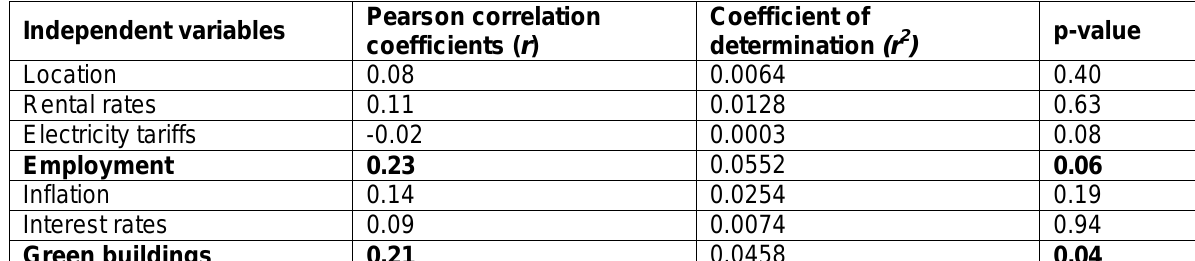
Table 6: Pearson correlation coefficients, coefficient of determination and probability values of the independent